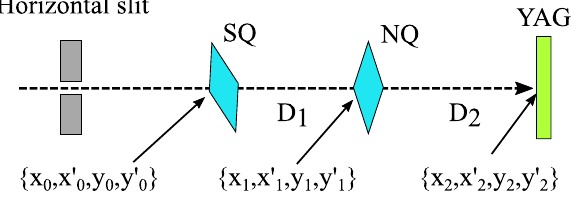
FIG. 1. Projection beam line. Schematic of the projection-based TPS diagnostic beam line for horizontal phase space measure- ment. The beam line consists of a horizontal slit, skew quad (SQ), normal quad (NQ), and YAG